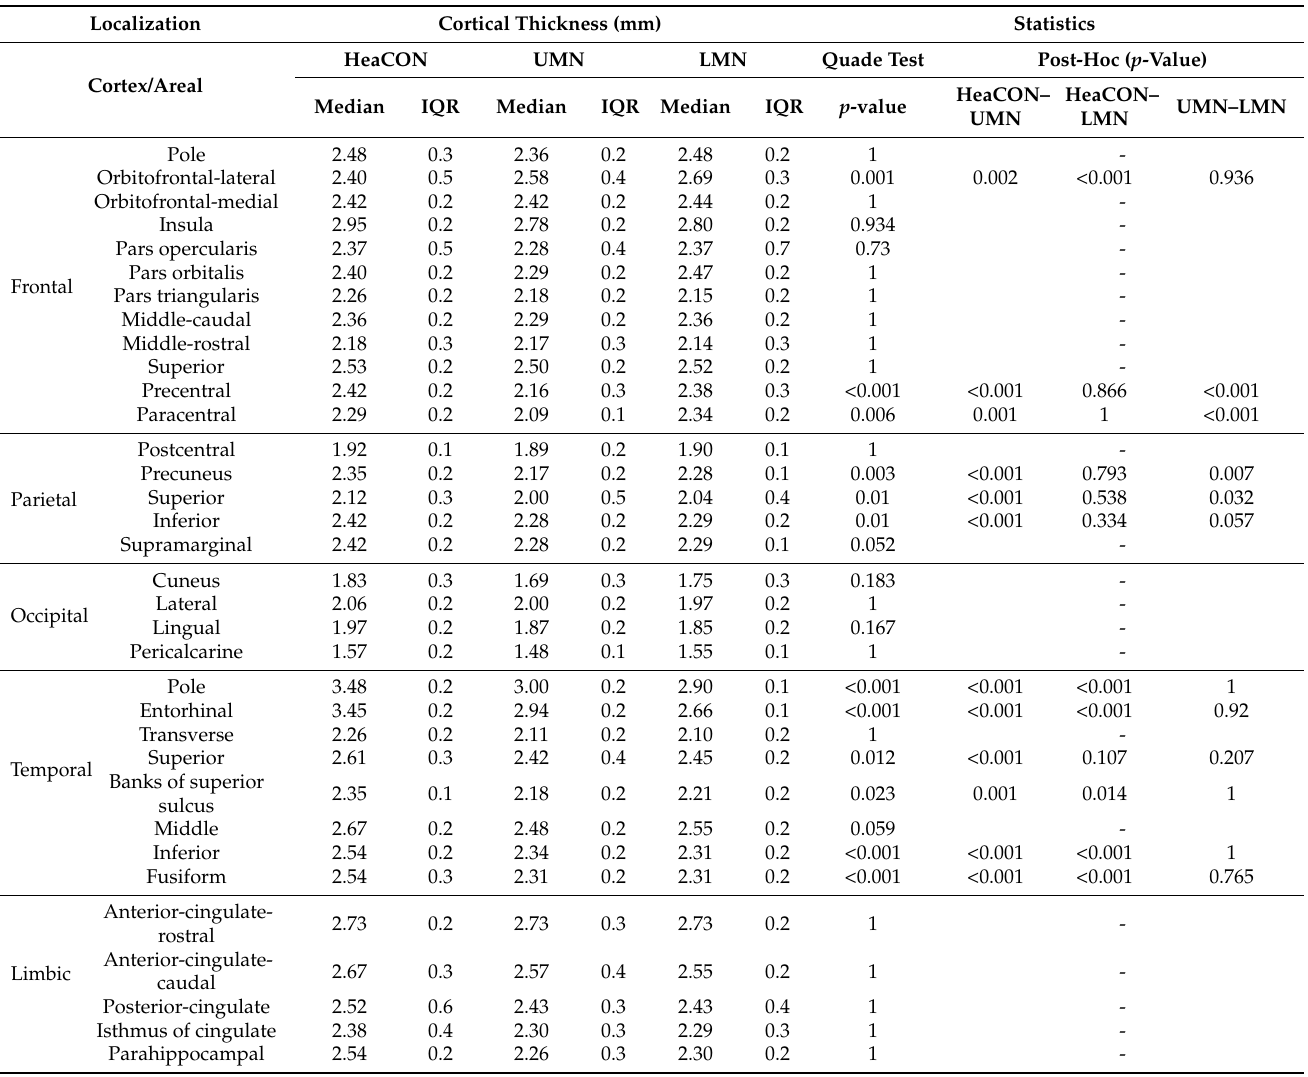
Table 3. Statistical results (descriptive, univariate) of cortical thickness from 34 different cortical regions of the left hemisphere in HeaCON, LMN and UMN. Significances were Bonferroni-corrected for multiple comparisons. HeaCON, healthy controls; LMN, lower motor neuron patients; UMN, upper motor neuron